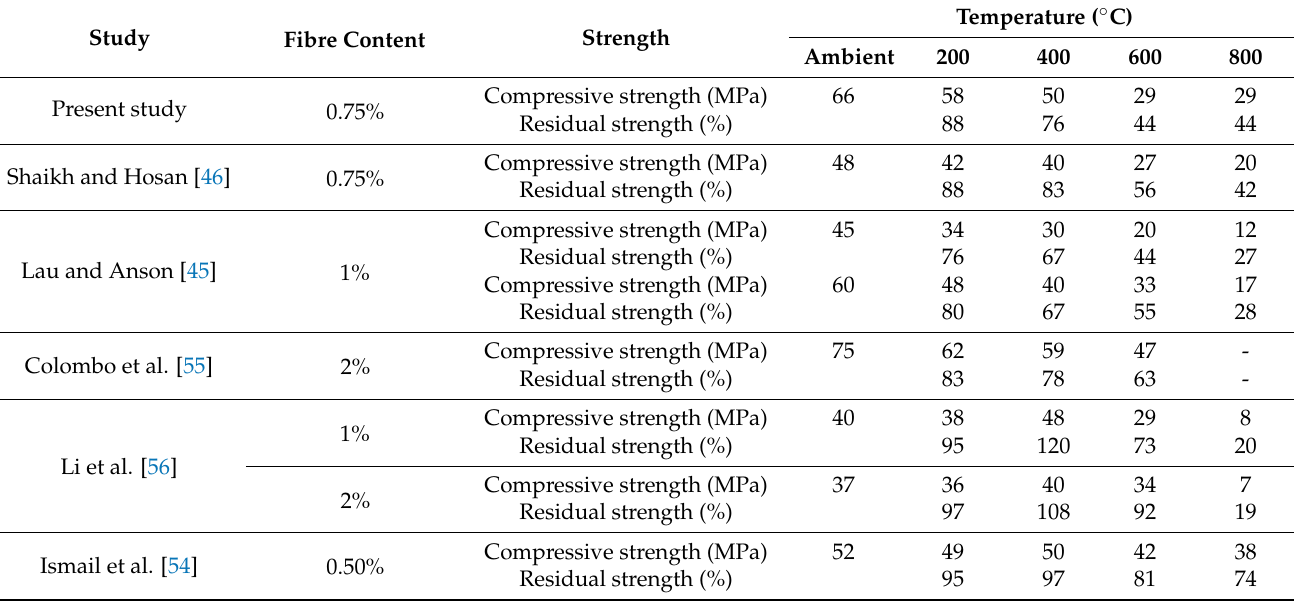
Table 3. Comparison of residual compressive strengths of steel fibre reinforced composites at elevated